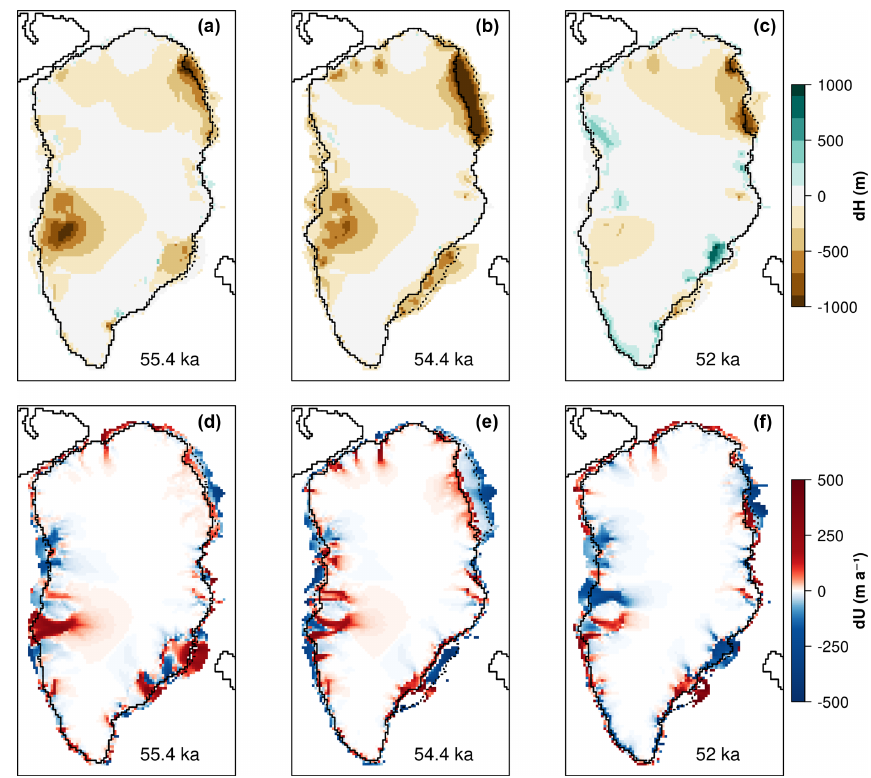
Figure 5. TOT max − ORB max ice thickness (m, a, b, c ) and velocities (m a − 1 , d, e, f ) during submarine melting rate peak corresponding to GS 15. TOT max and ORB max grounding-line positions are shown by solid and dashed lines, respectively.